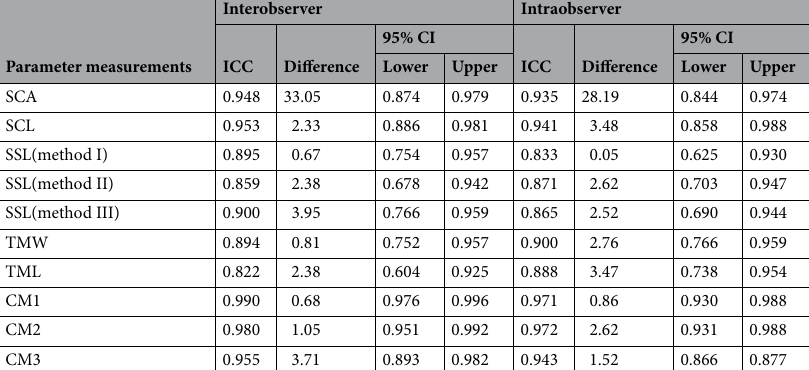
Table 2. Interobserver and intraobserver reproducibility of SC, SSL, TM and SC parameter measurements. Schlemm’s canal area (SCA, μm 2 ), Schlemm’s canal length (SCL, μm), Scleral spur length (SSL, μm),